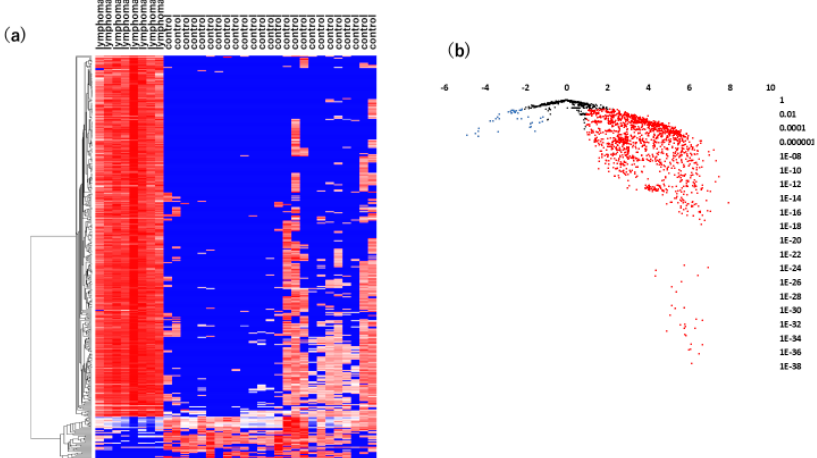
Figure 1. Analyses of vitreous miRNAs in VRL versus heathy controls. ( a ) Unsupervised hierarchical clustering analysis with a heatmap. The spectrum of dark red to dark blue color corresponds to high to low values. ( b ) Volcano plot of the fold change of miRNAs. Blue dots indicate downregulation, red dots indicate upregulation of miRNA and black dots indicate no significant difference.